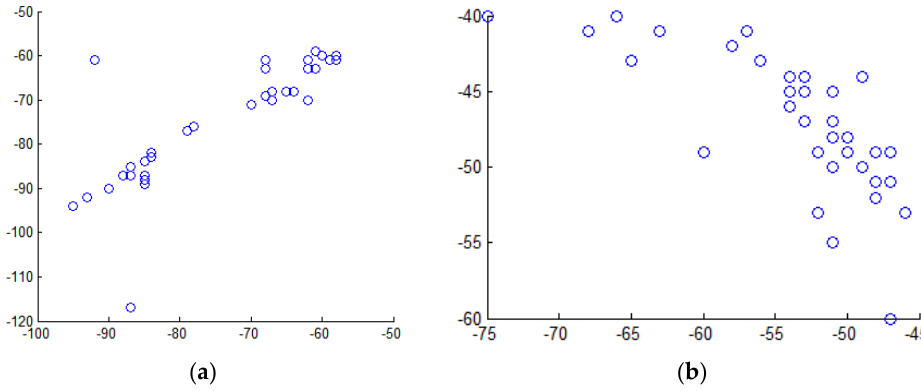
Figure 10. ( a ) Scatterplots of AP 2 and AP 7 at reference Location 1, r = 0.89; and ( b ) scatterplots of AP3 and AP17 at reference Location 2, r = −0.75.